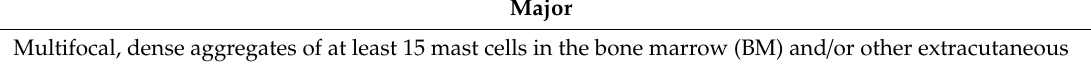
Table 1. Diagnosis of systemic mastocytosis based on World Health Organization criteria.